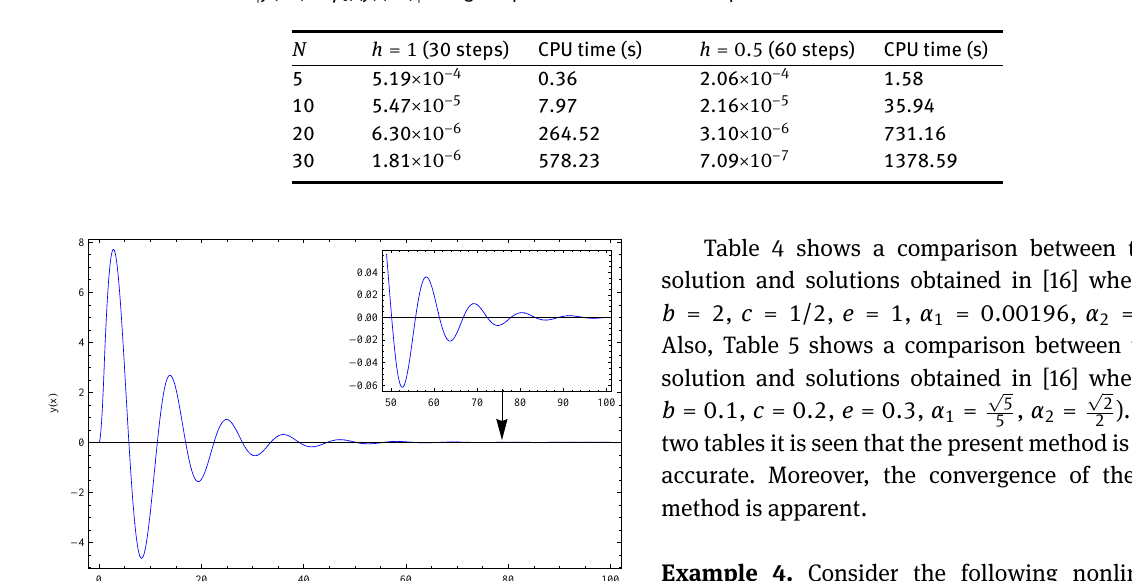
Table 3: Absolute errors | y (30) − ψ N ( y )(30) | using the present method for Example 2.